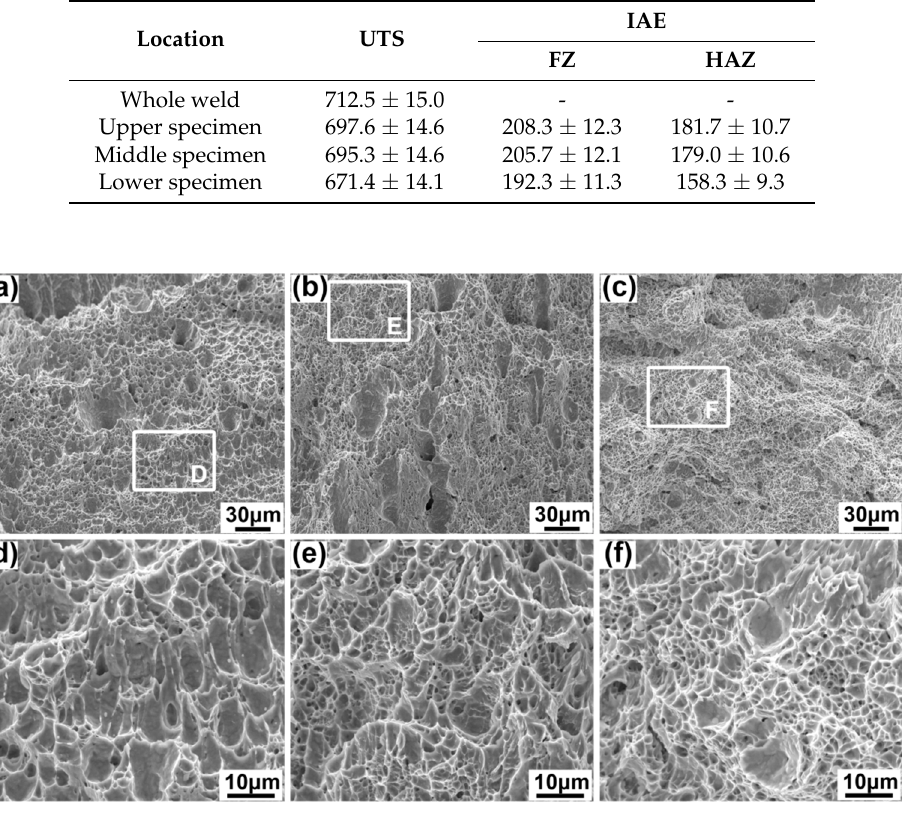
Figure 9. Fracture morphologies of the fusion zone (FZ) impact specimen at different parts, ( a ) the upper specimen; ( b ) middle specimen; ( c ) lower specimen; ( d ) details of area D; ( e ) details of area E; ( f ) details of area F.